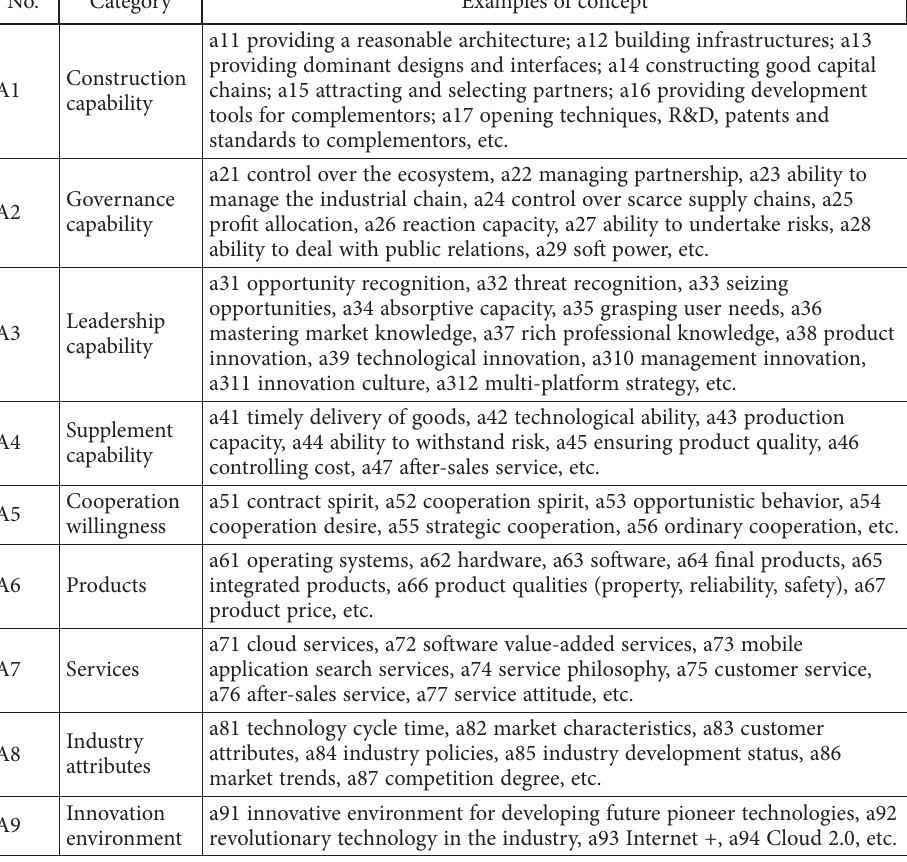
Table 3. Examples of open coding process